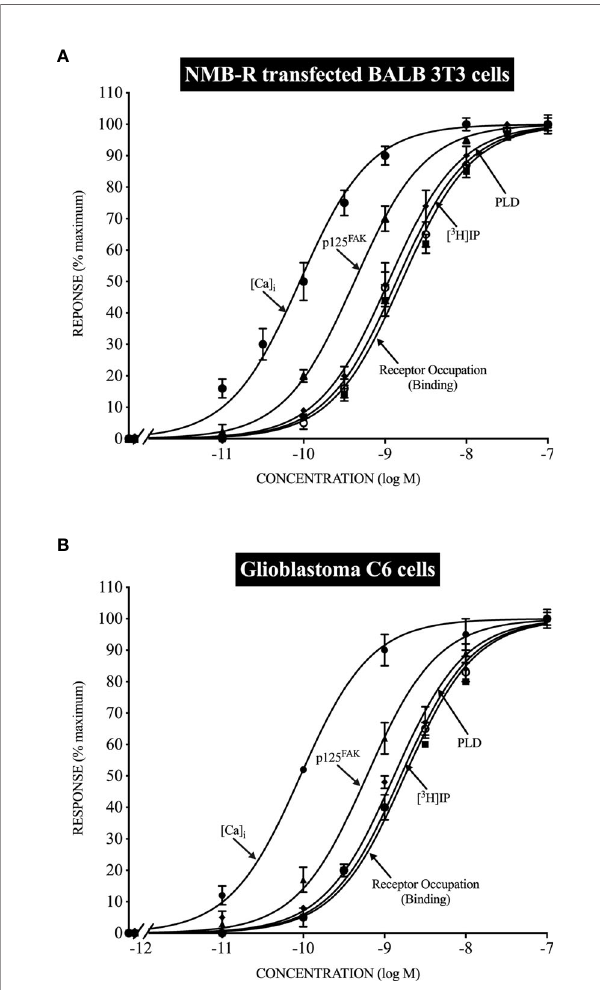
FIGURE 1 | Relationship between the ability of Neuromedin B to occupy NMB receptors (NMBR) and stimulate various intracellular signaling cascades in normal NMBR transfected cells (top, panel A ) and Glioblastoma C6-cells (bottom, panel B ). Stoichiometric relationships are drawn from data in (150, 151) and show the almost identical coupling in normal NMBR transfected cells (top) and Glioblastoma C6-cells (bottom) for NMBR occupation to activate phospholipase C, resulting in increases in cytosolic calcium ([Ca) i ] and stimulate the generation of phosphoinositides ( 3 H]IP); to activate phospholipase D, and the activation of p125focal adhesion kinase (p125 FAK